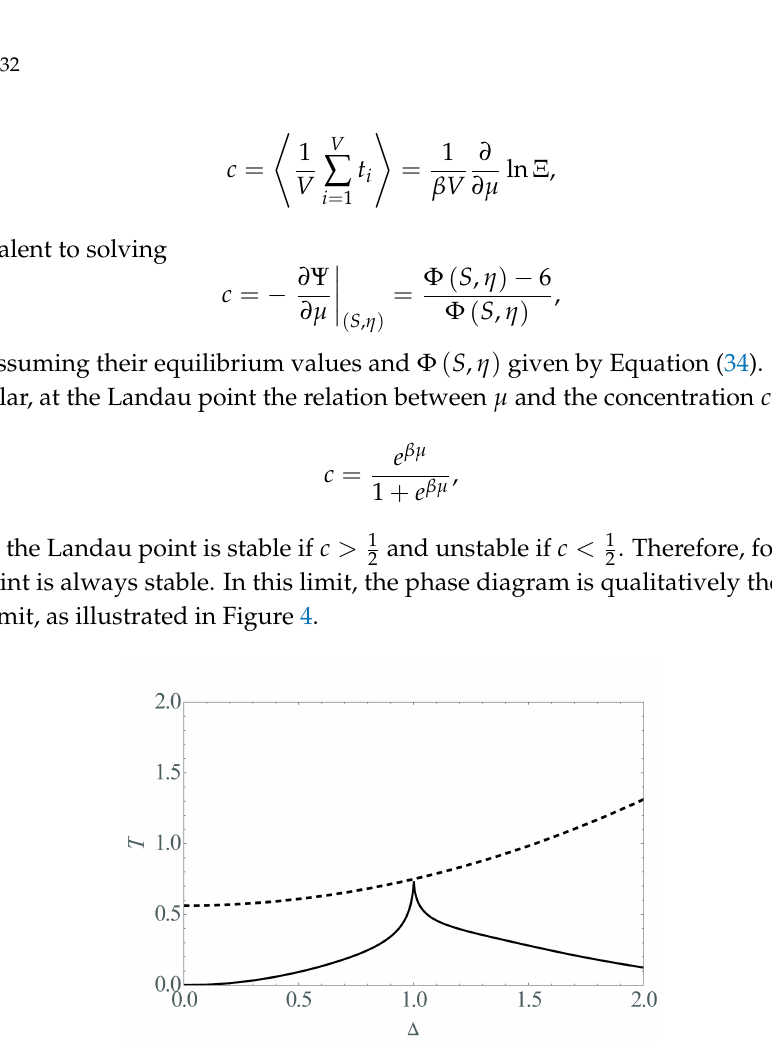
Figure 4. Zero-field phase diagram for the diluted model, when the concentration of nematogens corresponds to c = 0.75. Notice the lower temperature at the Landau point and a slightly more asymmetrical uniaxial–biaxial transition line around the line ∆ =